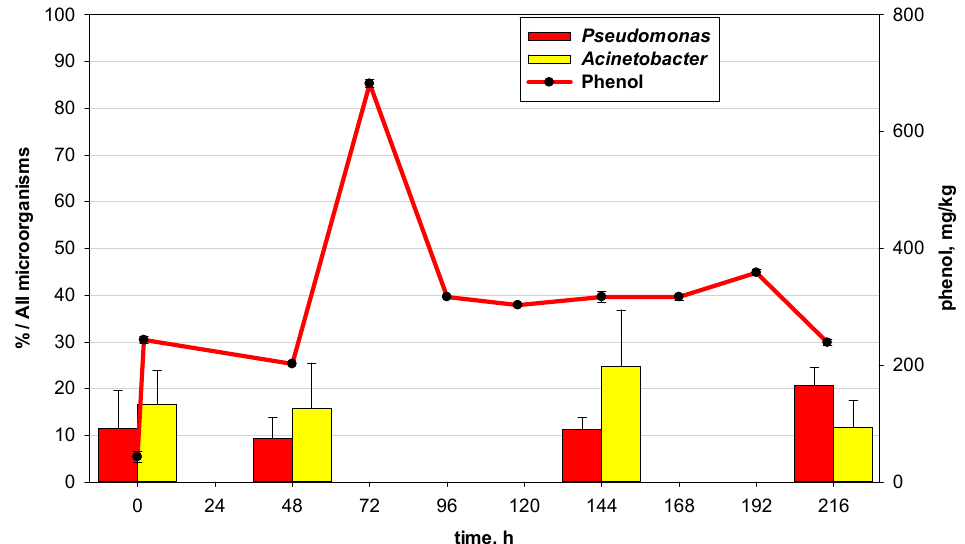
Figure 7. Percentage of non-culturable bacteria of the genus Pseudomonas and genus Acinetobacter and residual phenol concentration in the variant with added ND.